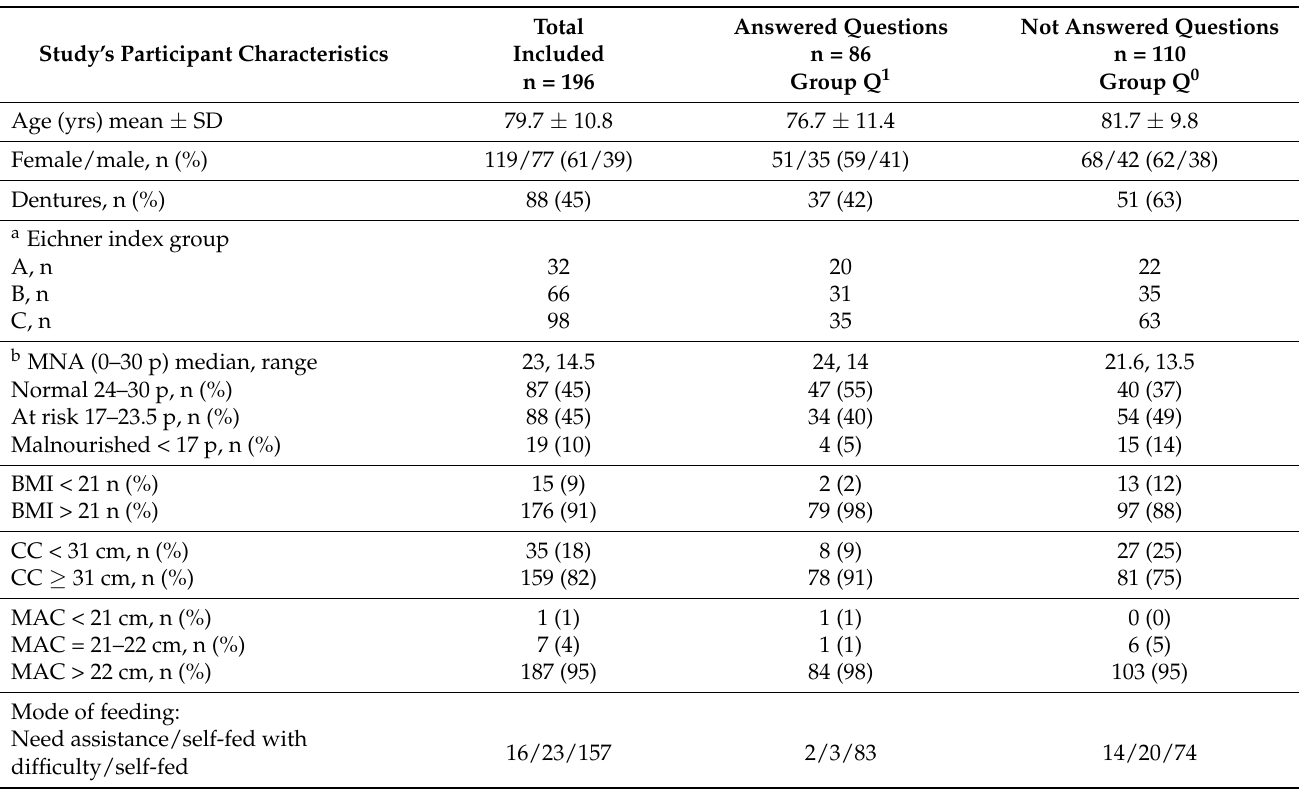
Table 1. Study’s participant characteristics. MNA = Mini Nutritional Assessment. CC = calf